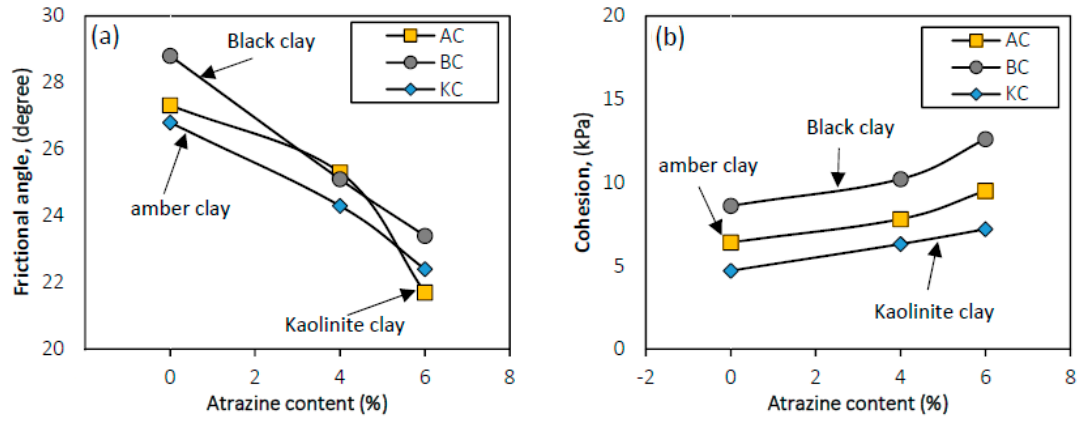
Figure 9. Effect of atrazine contamination on (a) Friction angle; (b) cohesion. Figure 9. E ff ect of atrazine contamination on ( a ) Friction angle; ( b )